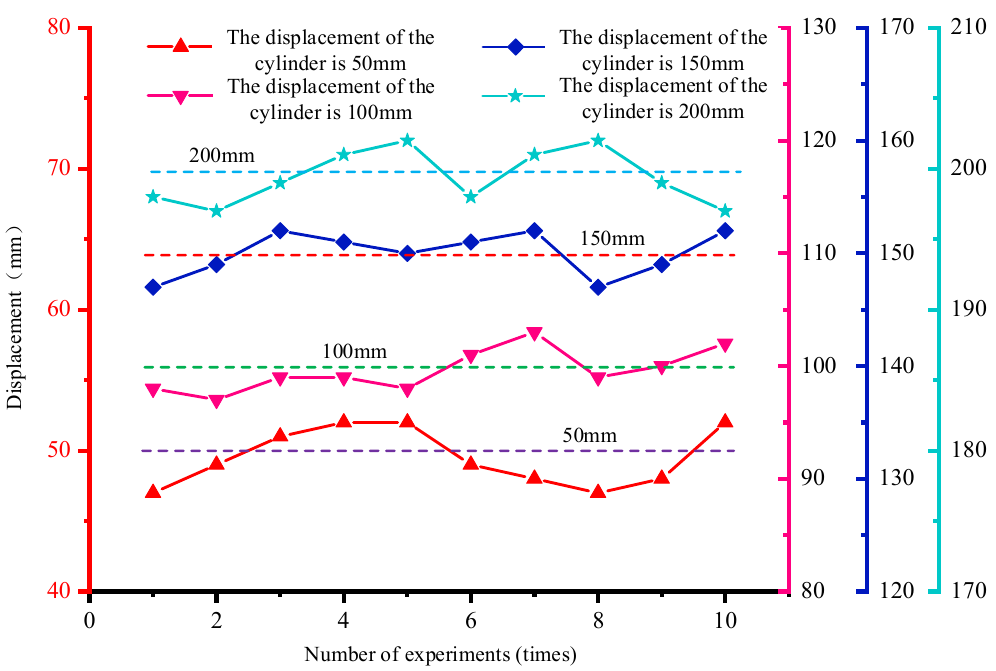
Figure 24. Displacement curve of the column cylinder of hydraulic support.